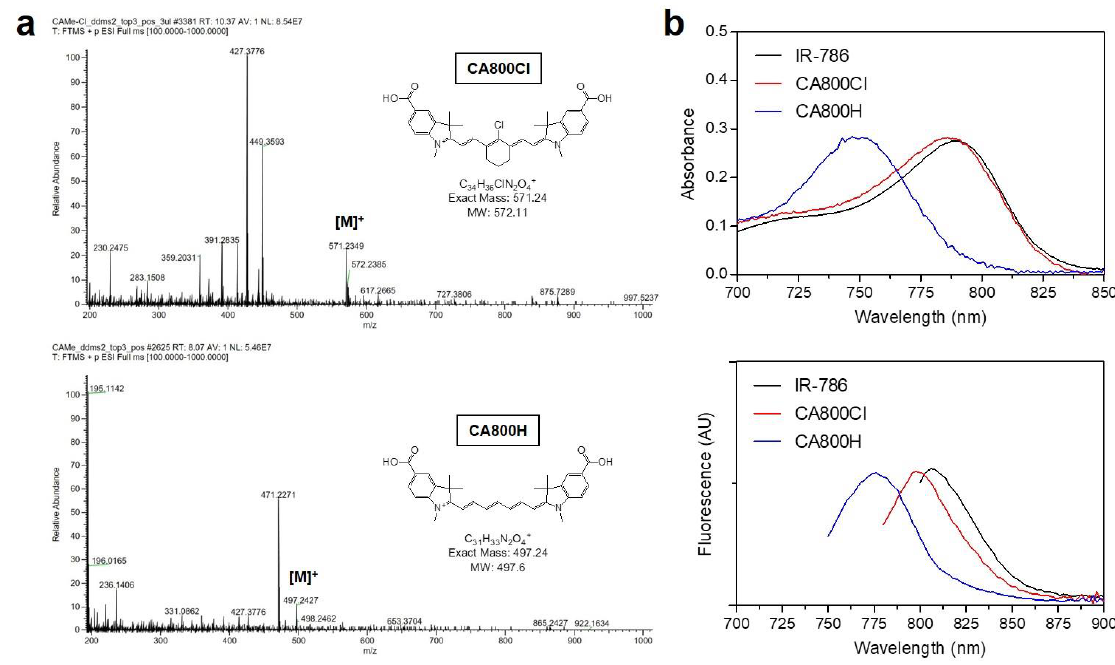
Figure 2. ( a ) Mass spectra of CA800Cl and CA800H NIR fluorophores. ( b ) Absorption spectra and fluorescence emission spectra of IR-786, CA800Cl, and CA800H NIR fluorophores. Optical measurements were performed in PBS, pH 7.4.